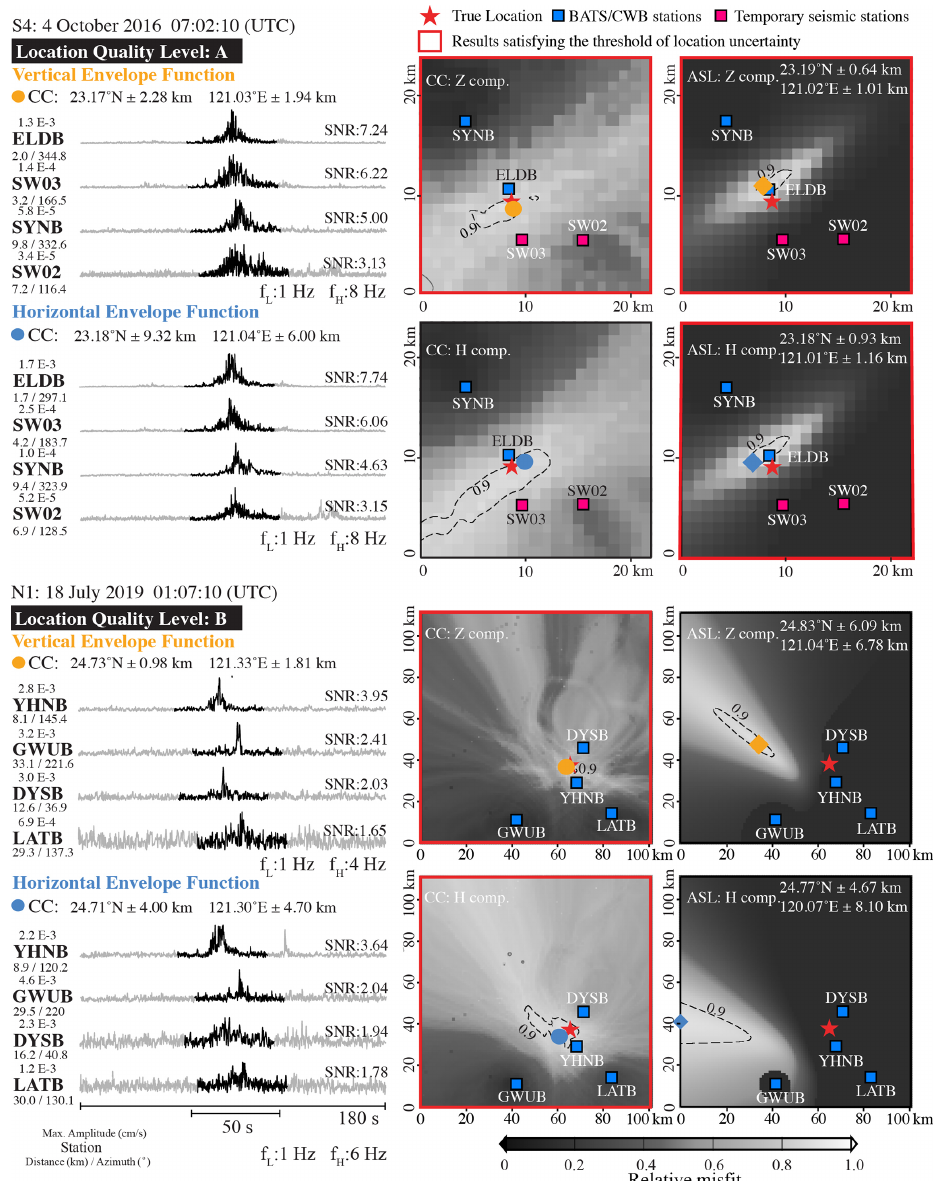
Figure 4. The result of CC and ASL in events S 4 and N 1. The left panel is the horizontal and vertical envelope function of the detected stations for events S 4 and N 1. The black lines with 50s signals are used in the CC. The right panel is the result of the CC and ASL with a horizontal and vertical component. The circle and diamond symbols present the best result of the CC and ASL, respectively. The black dashed lines are the contour of a relative misfit of 0.9. The uncertainty of the location is estimated based on the standard deviation of longitude and latitude for the source grid points with a relative misfit higher than